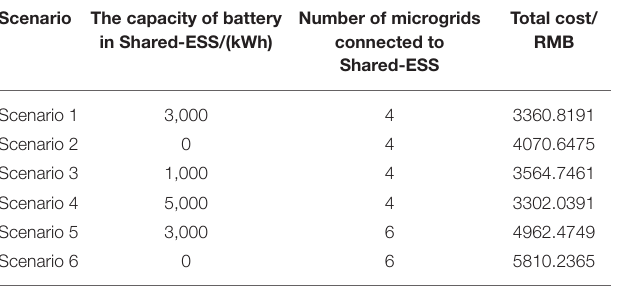
TABLE 1 | Introduction of different scenarios.